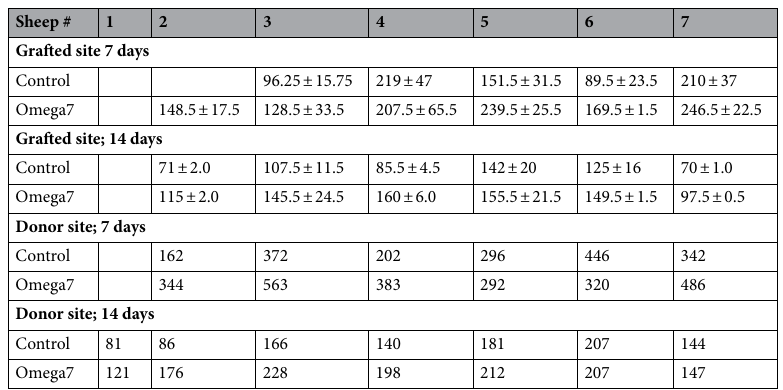
Table 1. Blood flow of grafted burn and donor sites at 7 and 14 days. Data are shown as mean ± SEM.